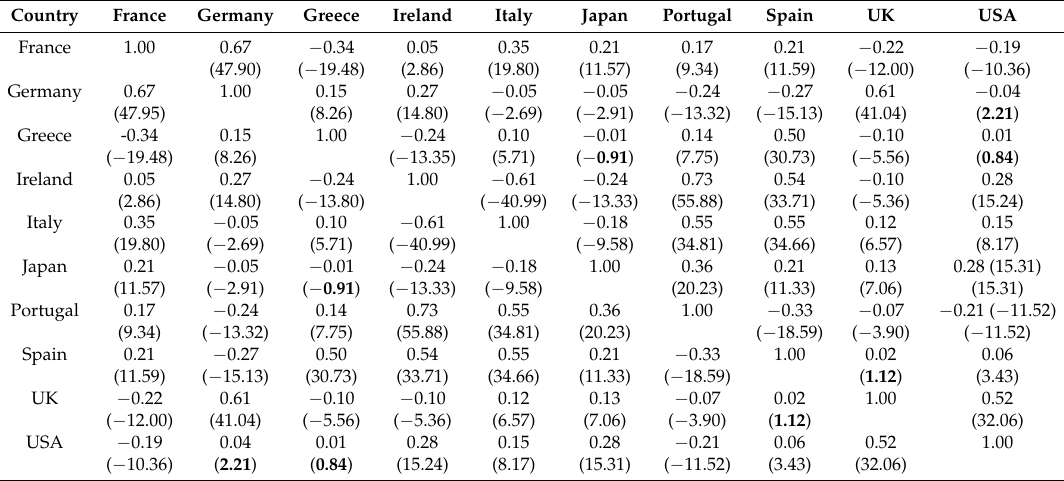
Table 2 indicates that the CDS spreads of some pairs of countries are indeed conditionally independent (their link is missing in Figure 1). From an economic viewpoint, this means that they do not directly have an impact on each other. Such conditional independence affects the pairs